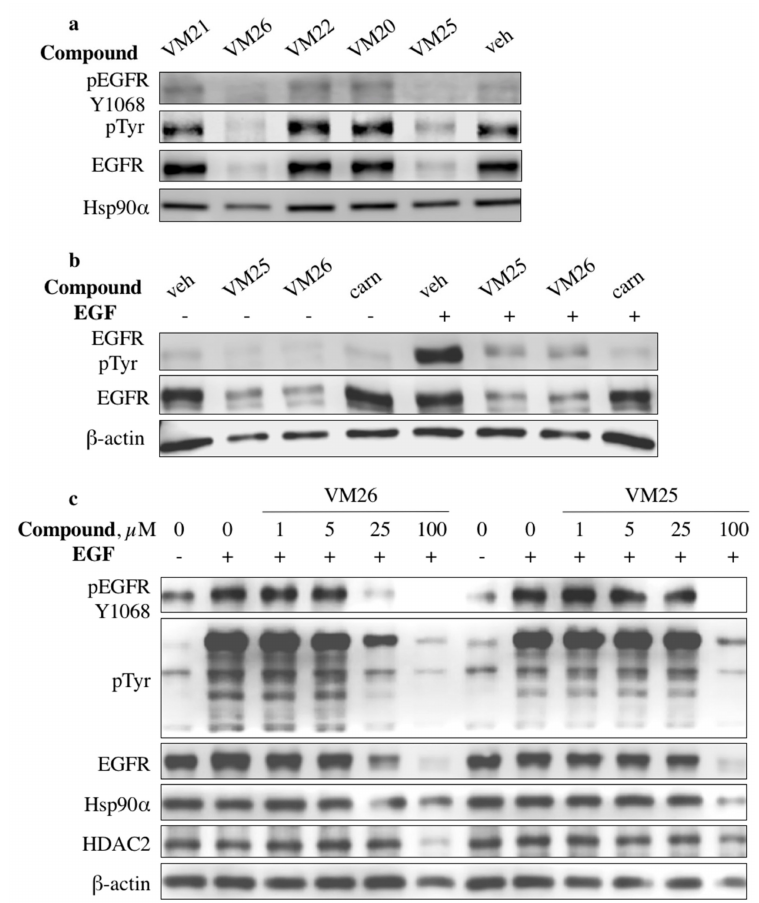
Figure 2. Small compounds decrease epidermal growth factor receptor (EGFR) expression in MDA-MB-468 cells. ( a ) Serum-starved MDA-MB-468 cells were incubated with vehicle (veh) and selected compounds at a concentration of 100 µ M for 2 h and then stimulated with 200 ng / mL EGF for 10 min. ( b ) Comparison of the action of the compounds VM25 and VM26 with canertinib (1 µ M). ( c ) Compounds VM25 and VM26 exhibit dose-dependent e ff ects on EGFR